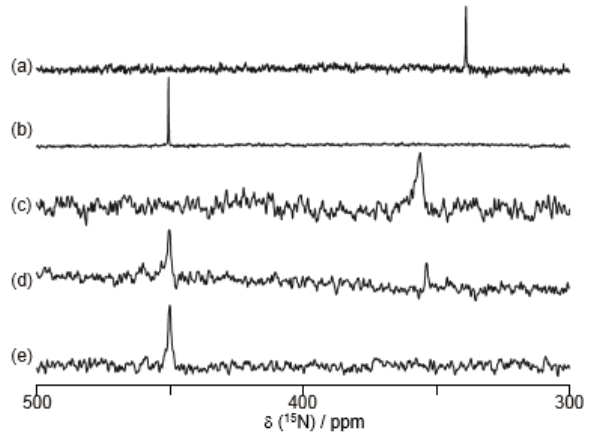
Figure 9. The 15 N NMR spectra of 8 (20 mM) under various conditions: ( a ) in D 1.0 M NaOD·D O solution; ( c – e ) in a mixed solvent (100 mM CHES buffer, 2 pH 10.0/DMSO- d = 3/1, v / v ); ( c ) without D -fructose; ( d ) in the presence of 0.10 M 6 D -fructose; and ( e ) in the presence of 1.0 M D -fructose. The 15 N-frequency (0 ppm) is 81.07646745 MHz. Reprinted with permission from [66]. Copyright 2010 The